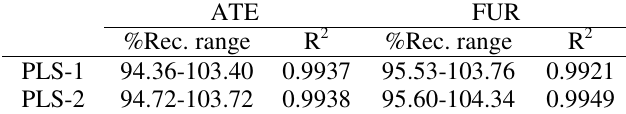
Table 5. Recovery range and R 2 for synthetic mixtures in test set.